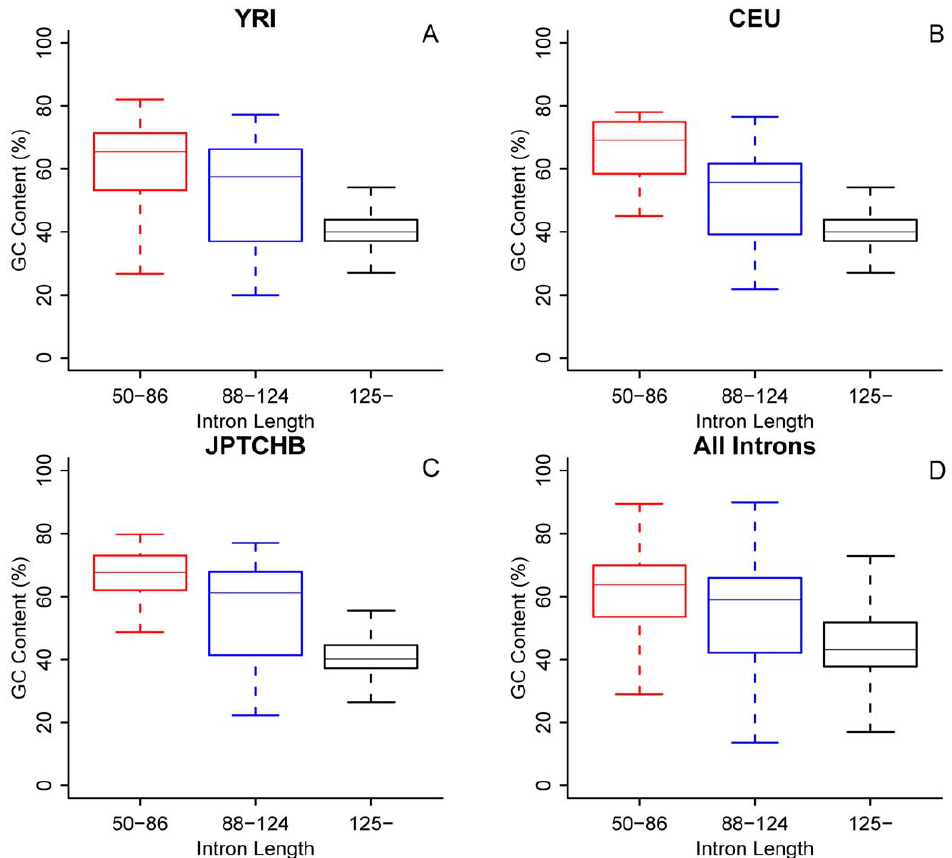
Figure 3. Relationship between GC content and intron size. GC contents in three size intervals from the three populations (DAF , 0.1): YRI (A), CEU (B), and JPTCHB (C) as well as the combined data (all introns; D). The horizontal lines in the boxplots indicate the upper, the median, and the lower quartiles (from the top to the bottom).